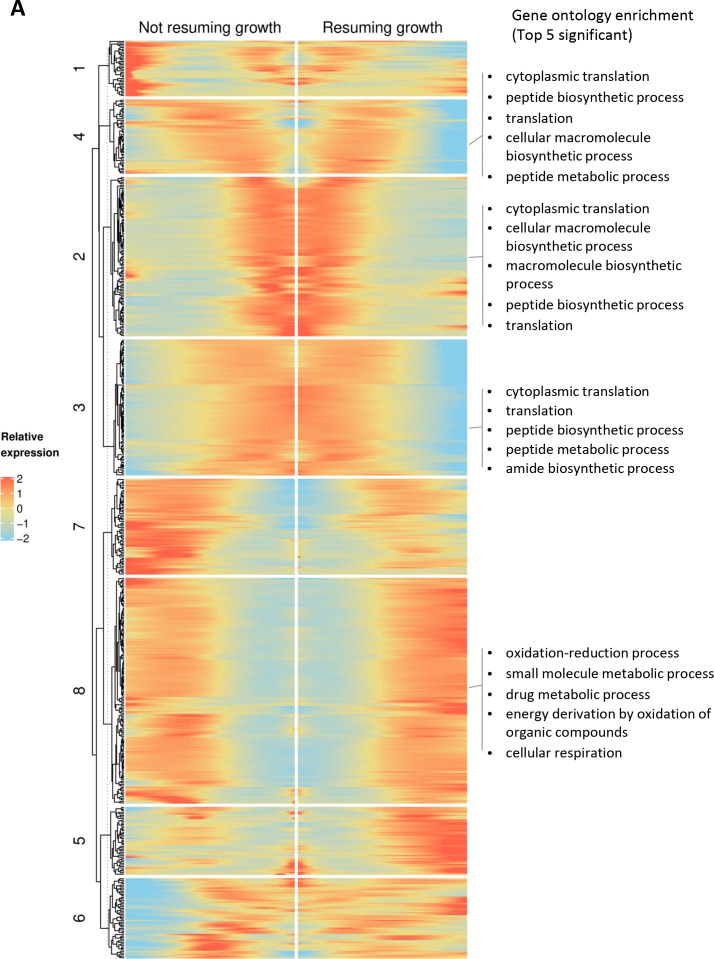
Branched expression analysis modeling (BEAM) using Monocle package showing co-expression patterns in continuously growing cultures.(A) Rows indicate genes expressed in a branch-dependent manner, and columns represent pseudo-time. The middle of x-axis represents the branching point, and progression from middle to right represents the trajectory of cells that grow in lag phase. Progression from middle to left represents the trajectory of the cells that cannot resume growth in lag phase. The list of the genes in each cluster is provided as Supplementary file 3.